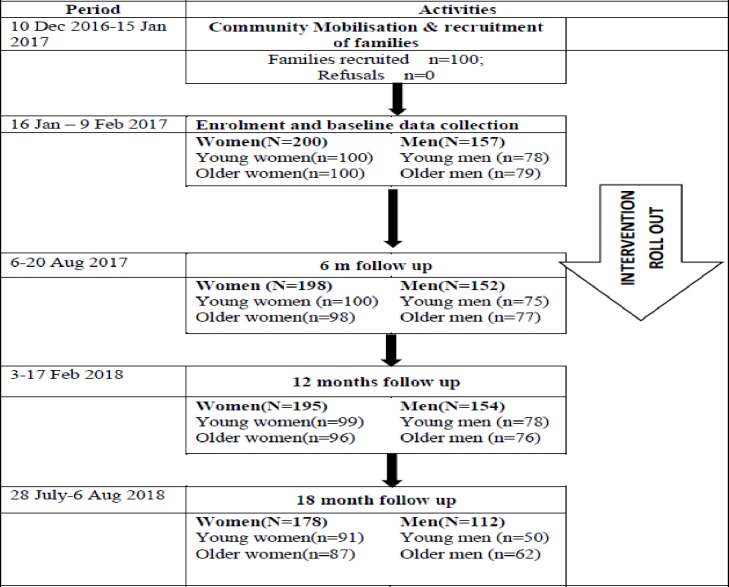
Flowchart of participants in the study.